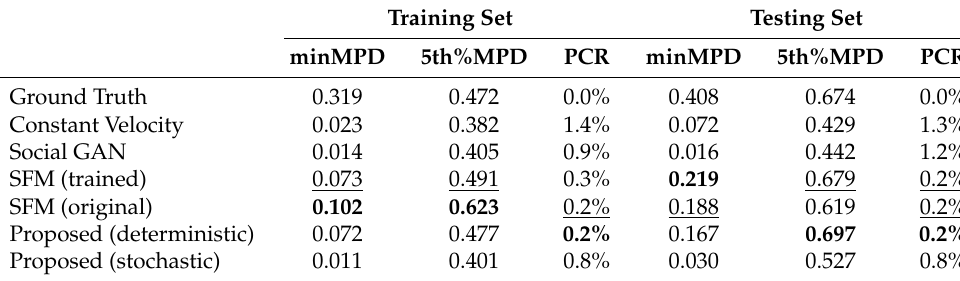
Table 7. Evaluation of MPD